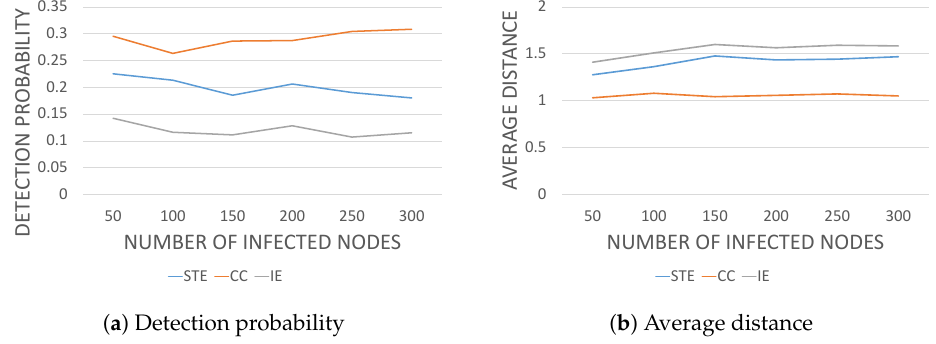
Figure 3. Performance of Sample-Tree-based Estimator (STE), Closeness Centrality (CC), and Infection Eccentricity (IE) in regular trees.